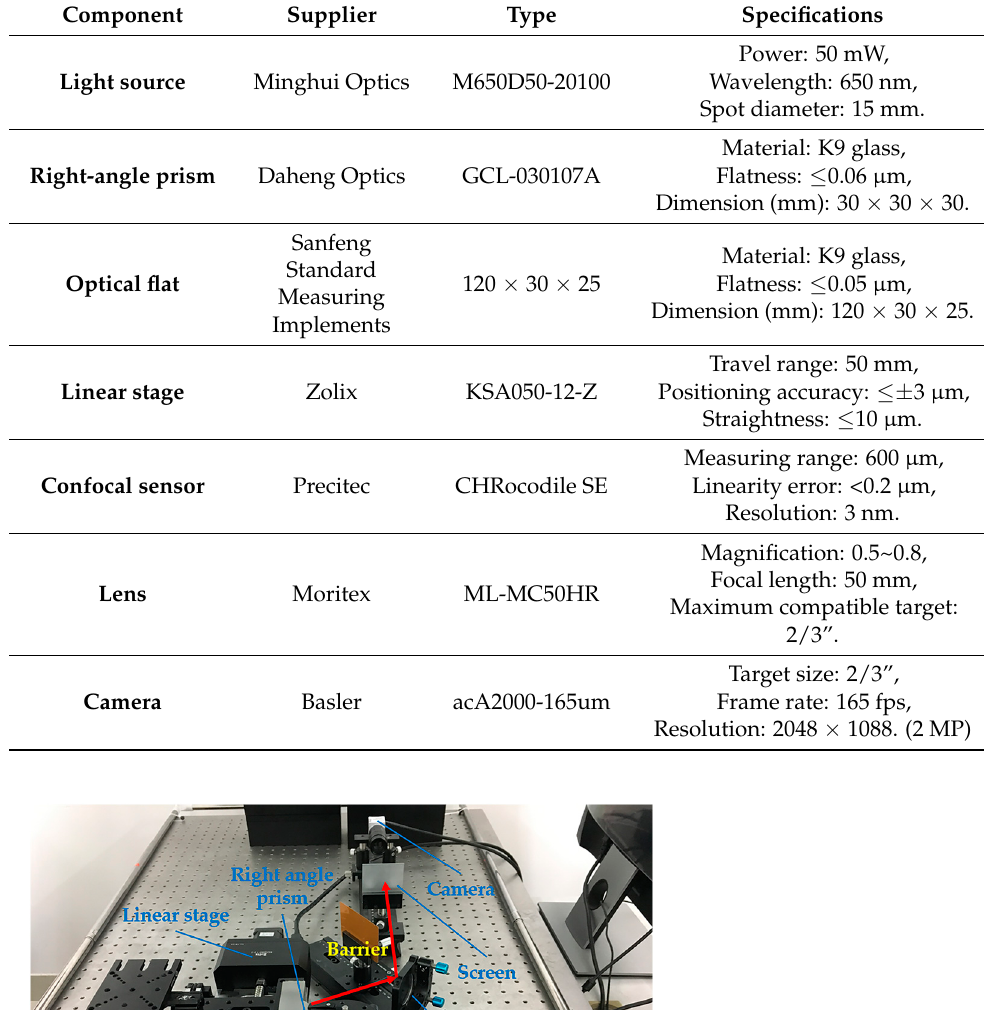
Table 2. Specifications of the key components.